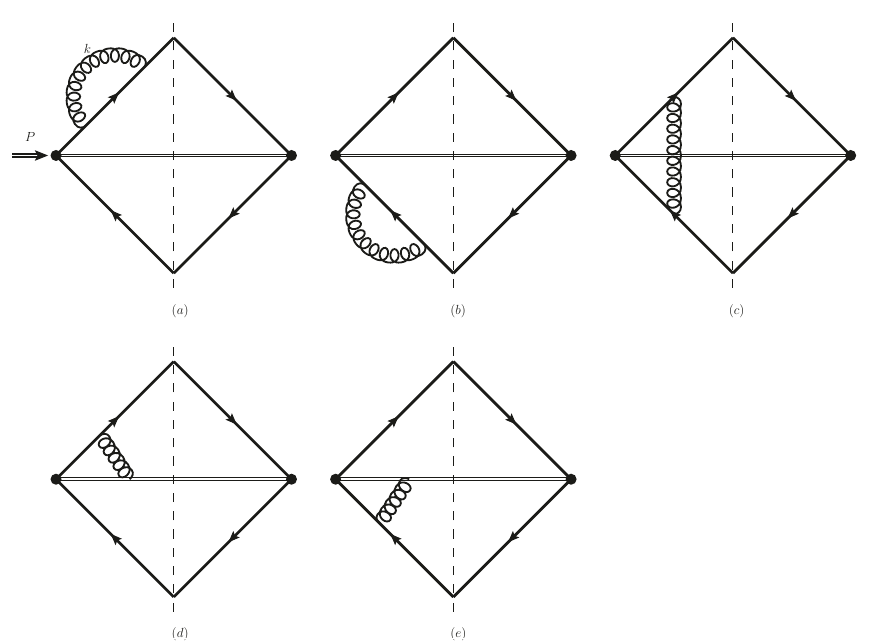
Figure 2 . The virtual corrections of SGD at NLO. The complex conjugate diagrams are not shown, but are included in the calculations.